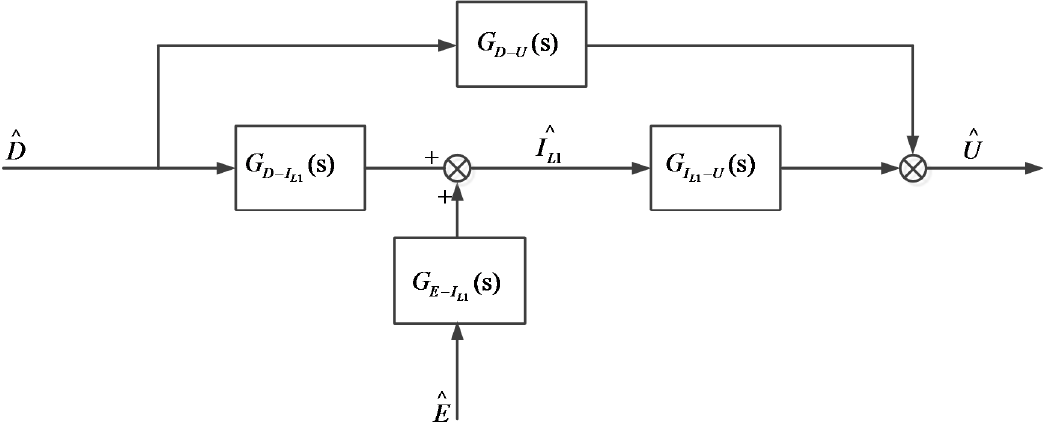
Figure 6. Small signal model of a dual-switch boost converter.